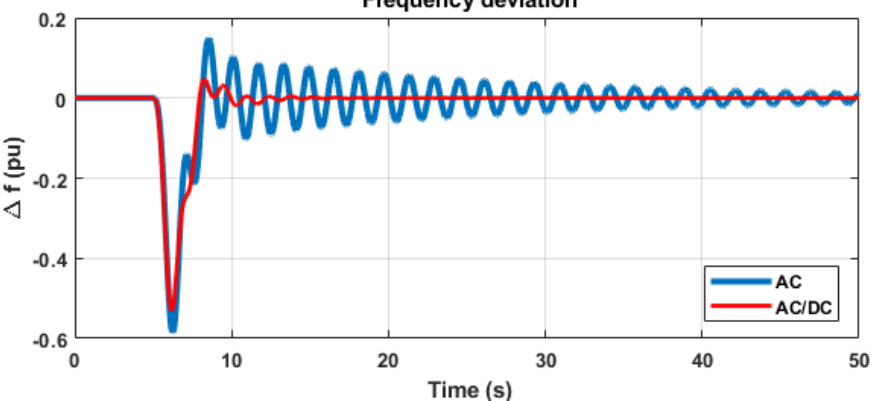
Figure 5. Frequency deviation comparison of AC and AC/DC